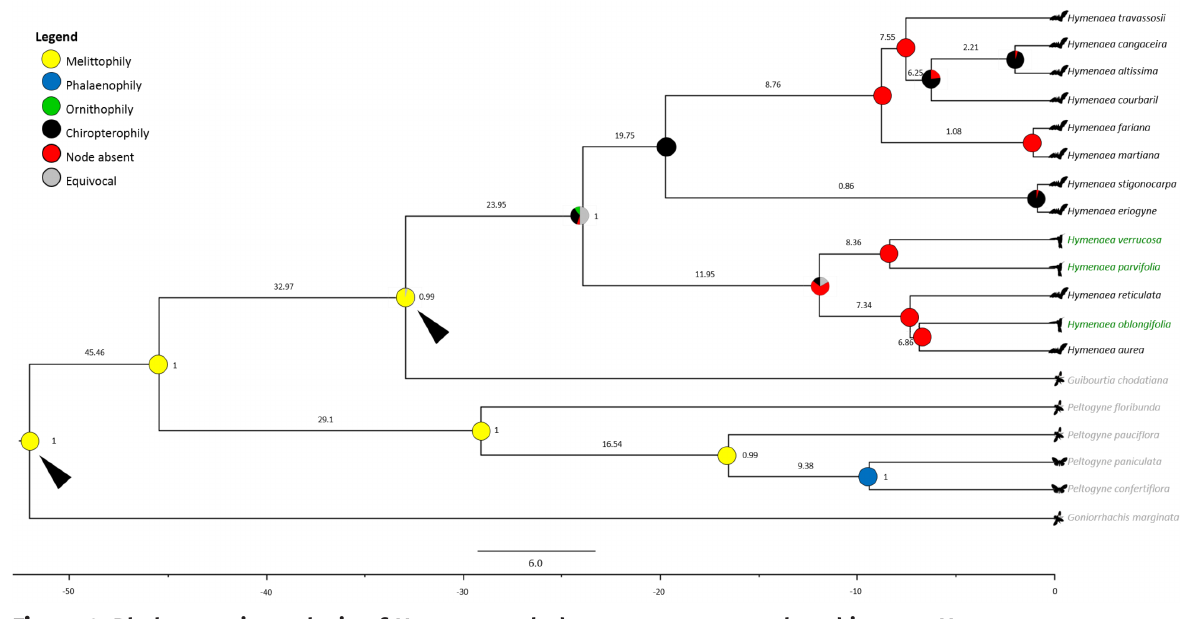
Figure 2. Phylogenetic analysis of Hymenaea clade: outgroups are colored in gray, Hymenaea sect. Hymenaea (sensu Lee & Langenheim 1975) is in black, and Hymenaea sect. Trachylobium (sensu Lee & Langenheim 1975) is in green. Summary of the Bayesian majority-rule consensus tree sampled, with optimization of pollination syndromes, and Maximum clade credibility tree of Hymenaea L. obtained from BEAST analyses. Numbers above branches are divergence time estimates. Black arrow refesr to the calibration point for the genus Hymenaea (Hueber & Langenheim 1986). Absent node mean an equivocal reconstruction node. Numbers on the nodes refer to the Bayesian posterior probabilities (only values >